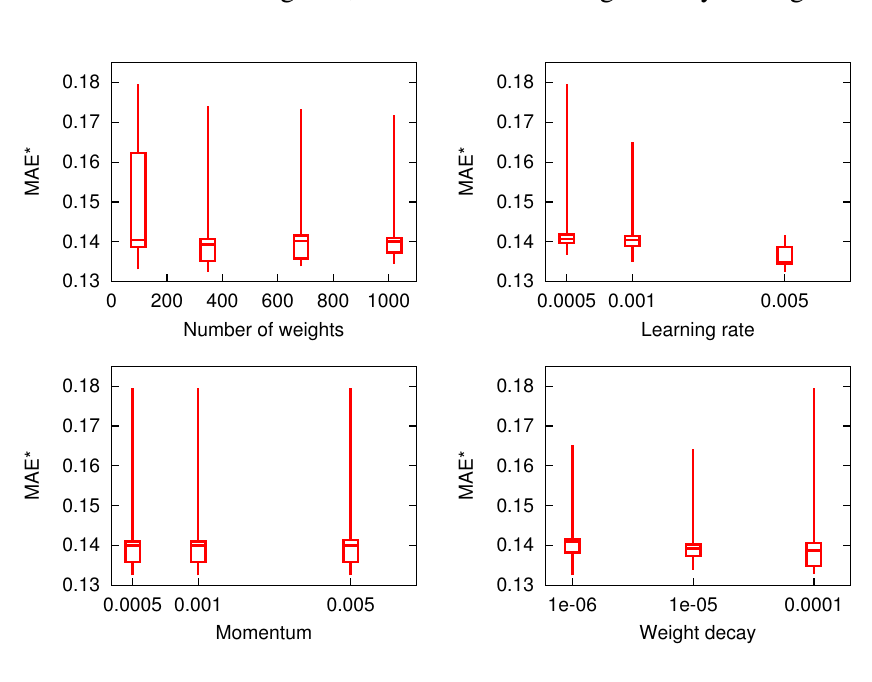
Figure 3. Mean absolute error (MAE) (cid:63) box-and-whisker plots for ANNs with one hidden layer and the hyper-parameters of the grid search performed to optimize the ANN model, d + h . The x-axis of the learning rate, momentum and weight decay are